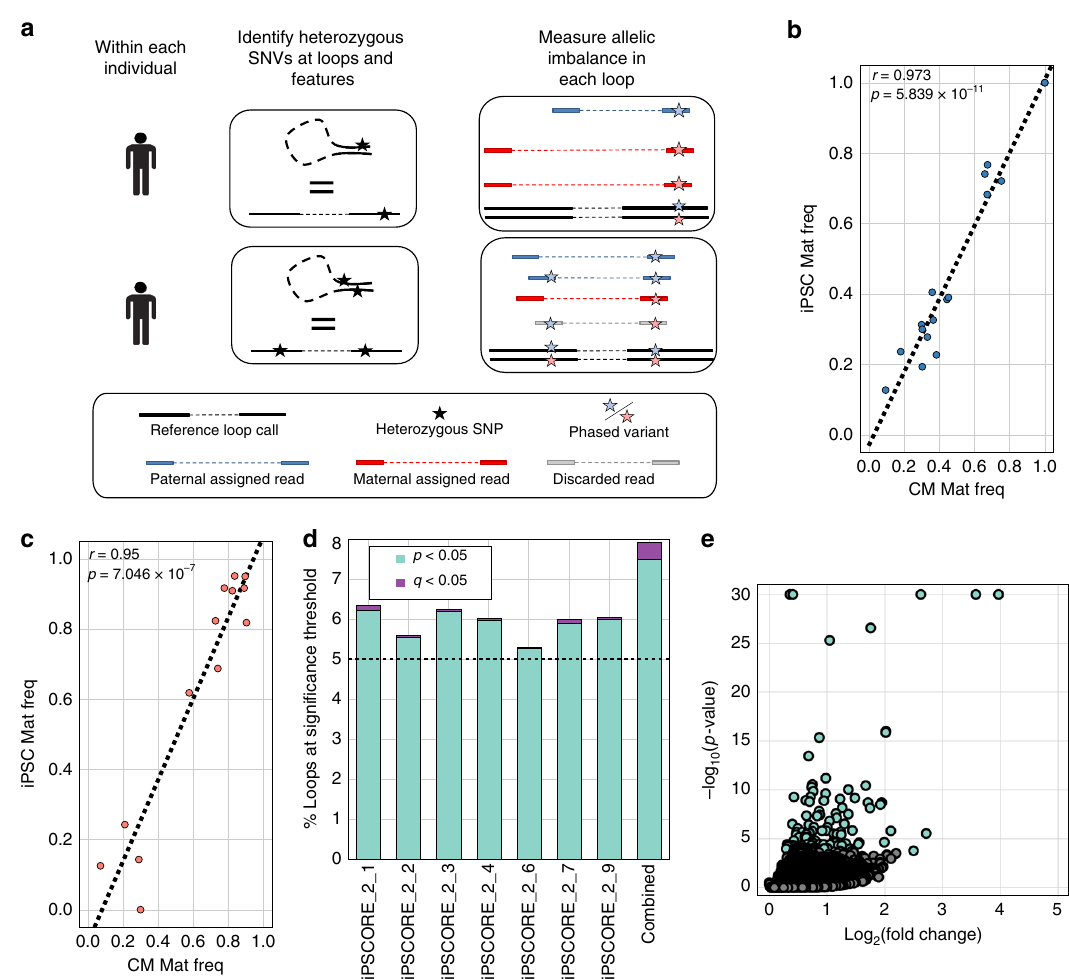
Fig. 5 Identi fi cation of haplotypic differences of chromatin conformation. a Schematic showing approach to quantify chromatin loop imbalance within each individual. Examples for two different individuals are shown. Variants were phased using Hi-C and family structure (see Methods), and each contact was assigned to its corresponding haplotype based on the phase of heterozygous SNVs it contained. Reference loop calls and unphased heterozygous SNPs are shown in black. Phased variants are shown in red for maternal, and blue for paternal. Reads only overlapping paternal phased variants were assigned to the paternal haplotype (blue reads), and read only overlapping maternal phased variants were assigned to the maternal haplotype (red reads). If a read overlapped both types of variants, it was discarded (gray read). b , c Scatter plot showing comparison between iPSC and iPSC-CM maternal haplotype frequencies for one of the seven individuals at HTALs identi fi ed in either b iPSCs or c iPSC-CMs. Linear regression correlation and p -value are reported for each cell type. Similar plots for all seven individuals are in Supplementary Figure 5. d Barplot showing the percent of loops associated with haplotype imbalance at p < 0.05 shown in teal, and with those also q < 0.05 shown in purple. Bars are shown for each individual separately, or for the results of a Fisher ’ s method meta-analysis p -value (Combined; right most bar). A dashed line is drawn at 5% to indicate the number of HTALs expected by chance to be signi fi cant at p < 0.05. e Volcano plot showing the log 10 ( p -value) vs the log 2 (fold change of allelic imbalance ratio, with the higher frequency allele always in the numerator of the ratio; see Methods) for each loop with the combined data. As only fold changes of major allele frequencies can be calculated due to haplotypes not having a single reference or alternate allele, all fold changes are positive. Signi fi cant points (HTALs) are shown in